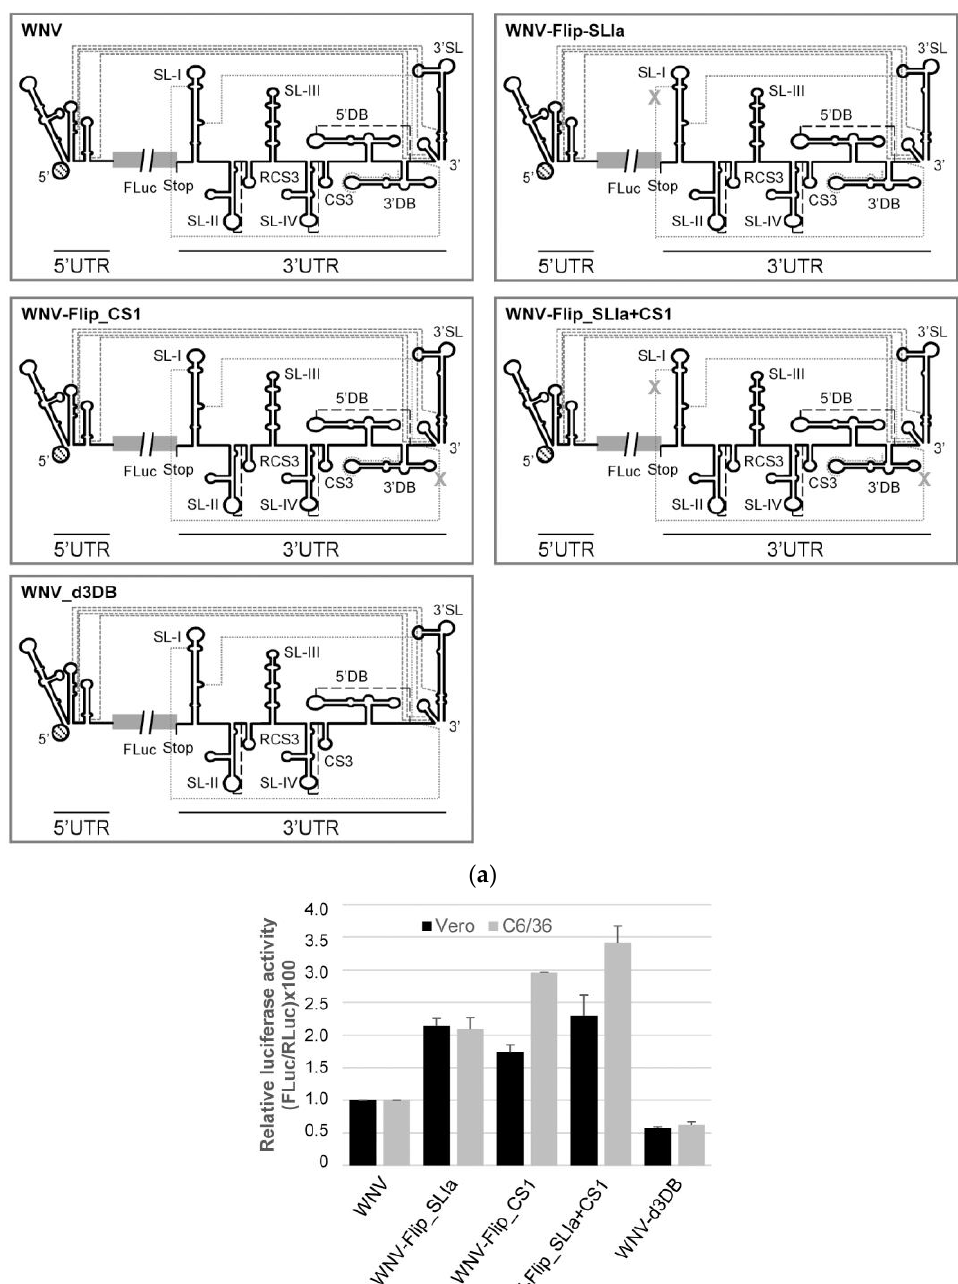
Figure 7. Changes in the dimerization efficiency correlate with WNV 5 ′ UTR-dependent protein synthesis. ( a ) Diagrams show different constructs used in this study harboring the FLuc coding sequence flanked by the WNV 5 ′ and 3 ′ UTRs. The mutations described in Figure 5 were included in the 3 ′ UTR to assay their role in translation regulation. ( b ) The translation efficiency of the constructs shown in ( a ) was measured in both Vero and C6/36 cell lines. Cells were cotransfected with each RNA construct and cap-RLuc RNA in order to normalize transfection efficiency. FLuc activity was measured at 4 h post-transfection. The histogram shows relative luciferase values relative to that obtained for the wt construct, WNV. Values are the mean of four independent assays ± standard deviation.